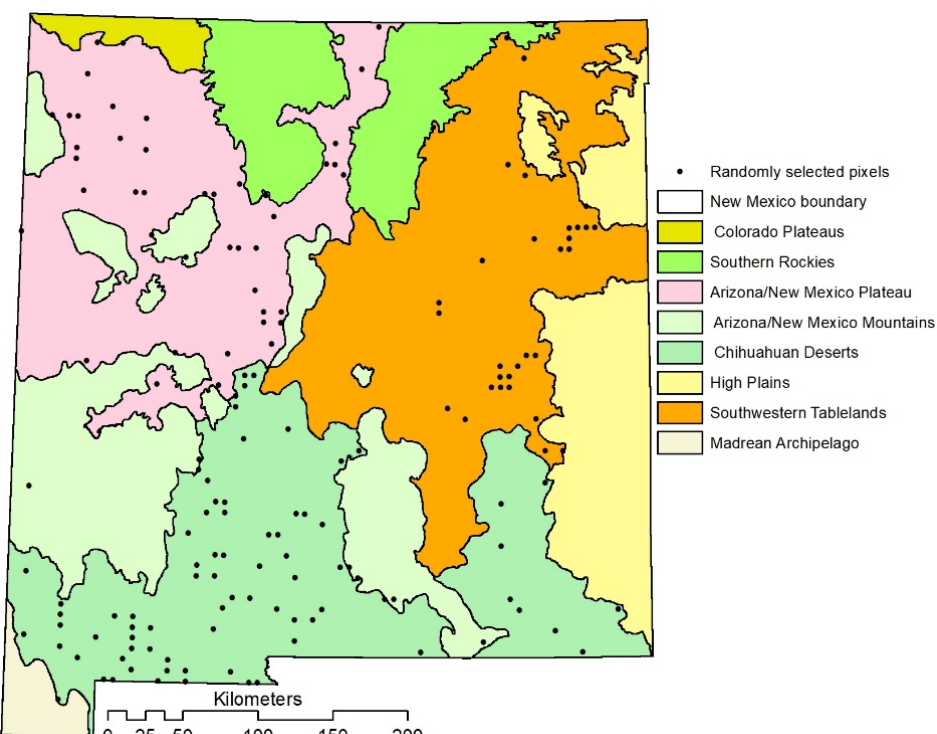
Figure 9. The distribution of the randomly selected samples from the identified breakpoints based on the Segmented VPR method along with the ecoregions in New Mexico. Table 4. The percentages of pixels with decreasing and increasing trends in productivity as estimated from the RPMS data relative to randomly selected pixels (155) based on the Segmented VPR method categorized based on their significance of difference in mean productivity before and after the break years over major ecoregions in New